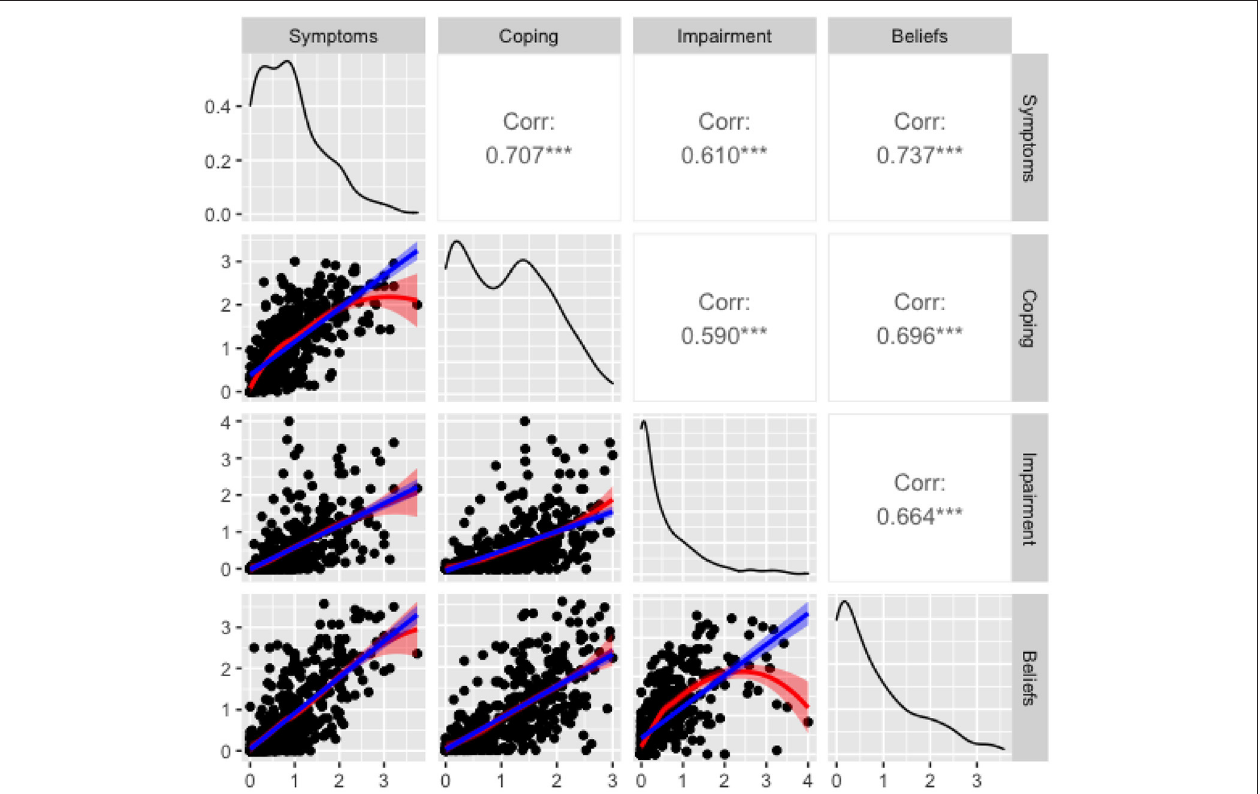
FIGURE 2 | Pairwise scatter plots of the four Duke Misophonia Questionnaire subscale scores (symptoms, coping, impairment, and beliefs). Linear (blue) and loess (red) regression lines are overlaid on each scatter plot. The empirical density of each subscale score in the current sample is shown on the diagonal. *** p < 0.001